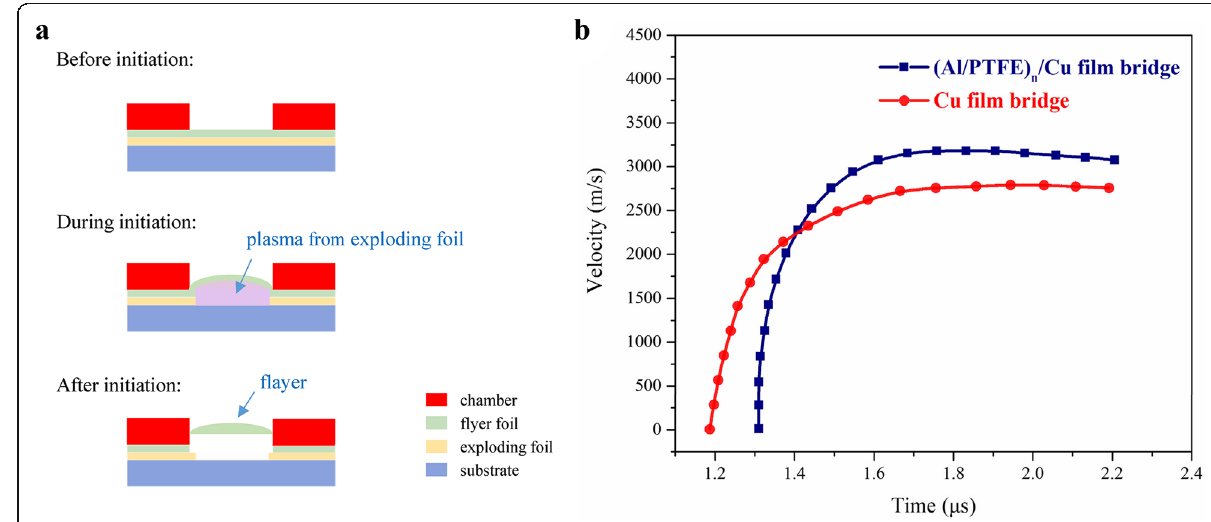
Fig. 7 a Schematic illustration side view of EFI operation in electric initiation process. b The velocity variation curves reconstructed from PDV signal during the electric initiation processes for the Cu film bridge and the (Al/PTFE) n /Cu film bridge at a 2500-V discharge